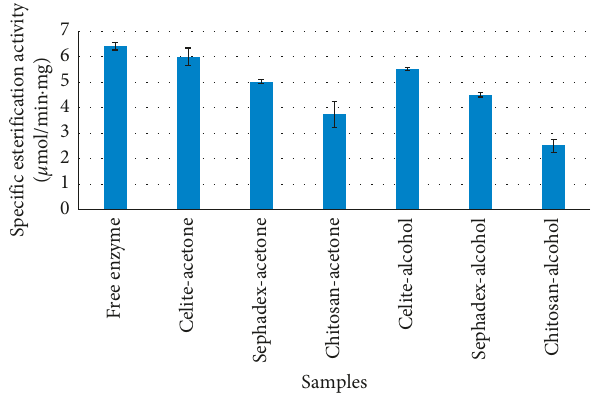
Figure 7: Timeline of hydrolysis reaction at [S] and temperature 45 ° C).